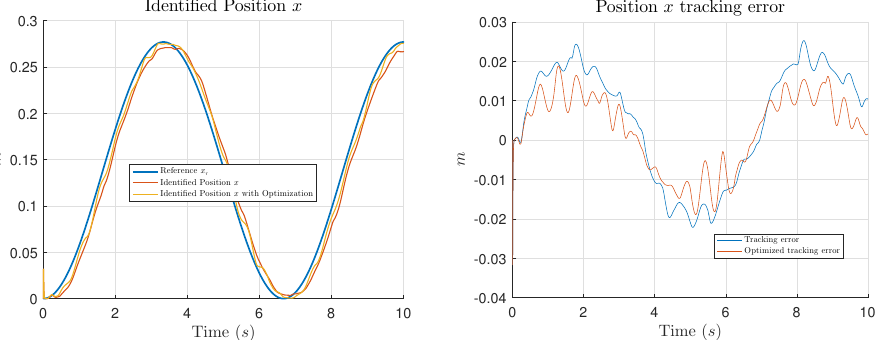
Figure 12. Tracking of x position ( left ) and error comparison ( right ) for the experimental test 2.